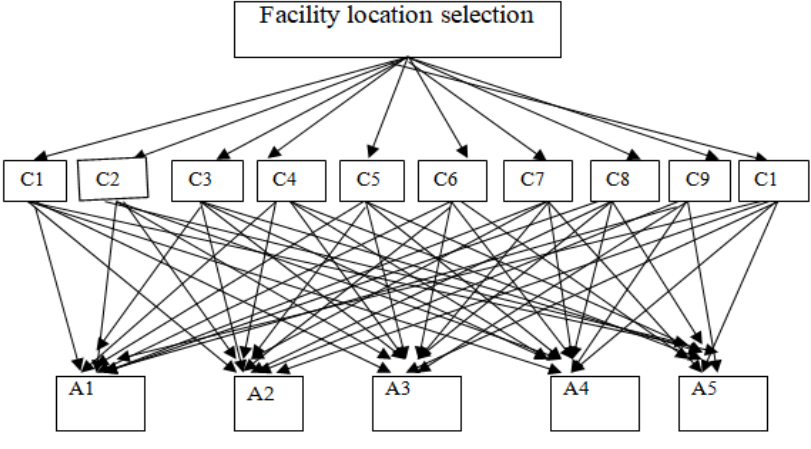
Figure 1. Hierarchy for the Facility Location